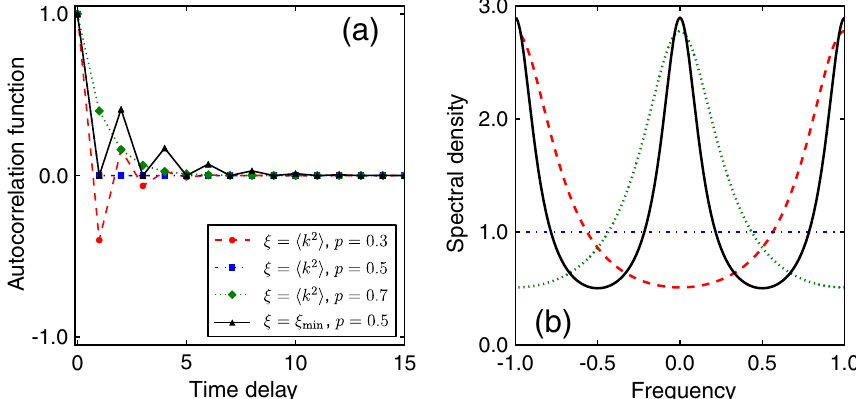
FIG. 4. Random-walk dynamics. We consider two interconnected networks composed of N ¼ 8192 nodes. Degrees are extracted from a power-law distribution with exponent γ ¼ 2 . 5 defined on the support ½ 32 ; N (cid:1) . We monitor the trajectory of a random walker moving on these systems for different values of the correlation term ξ and different values of the weight of the intralayer connections p . (a) Autocorrelation function R ð τ Þ ¼ h x ð t Þ x ð t þ τ Þi as a function of the time delay τ . In the definition of R ð τ Þ , x ð t Þ ¼ þ 1 if the random walker does not change network layer at time t , and x ð t Þ ¼ − 1 otherwise. (b) Spectral density S ð ω Þ of the autocorrelation functions of (a). Intralayer movements are characterized by the presence of a peak of S ð ω Þ at ω ¼ 0 , while interlayer jumps are emphasized by the presence of peaks at ω ¼ (cid:4) 1